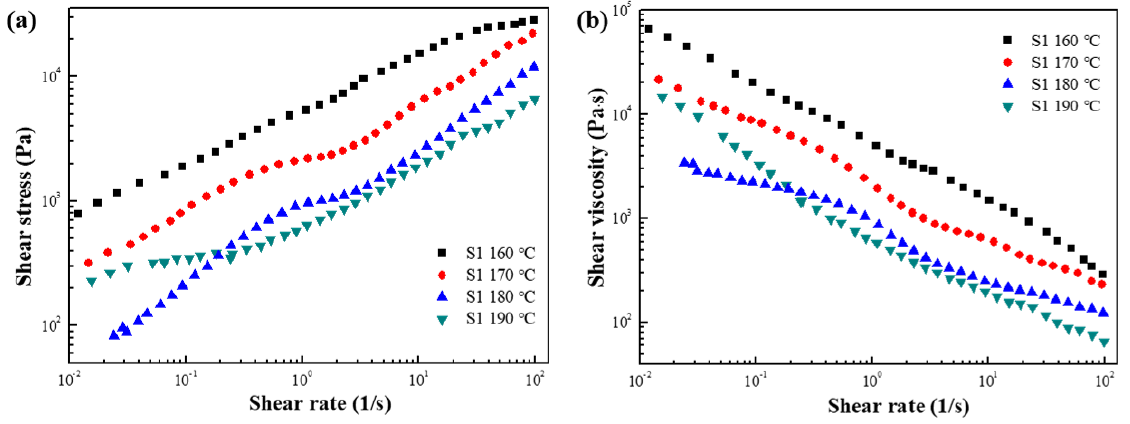
Figure 4. Storage (closed symbols) and loss (open symbols) modulus of ( a ) temperature sweep test and ( b ) strain amplitude sweep test for S1 at various temperatures.